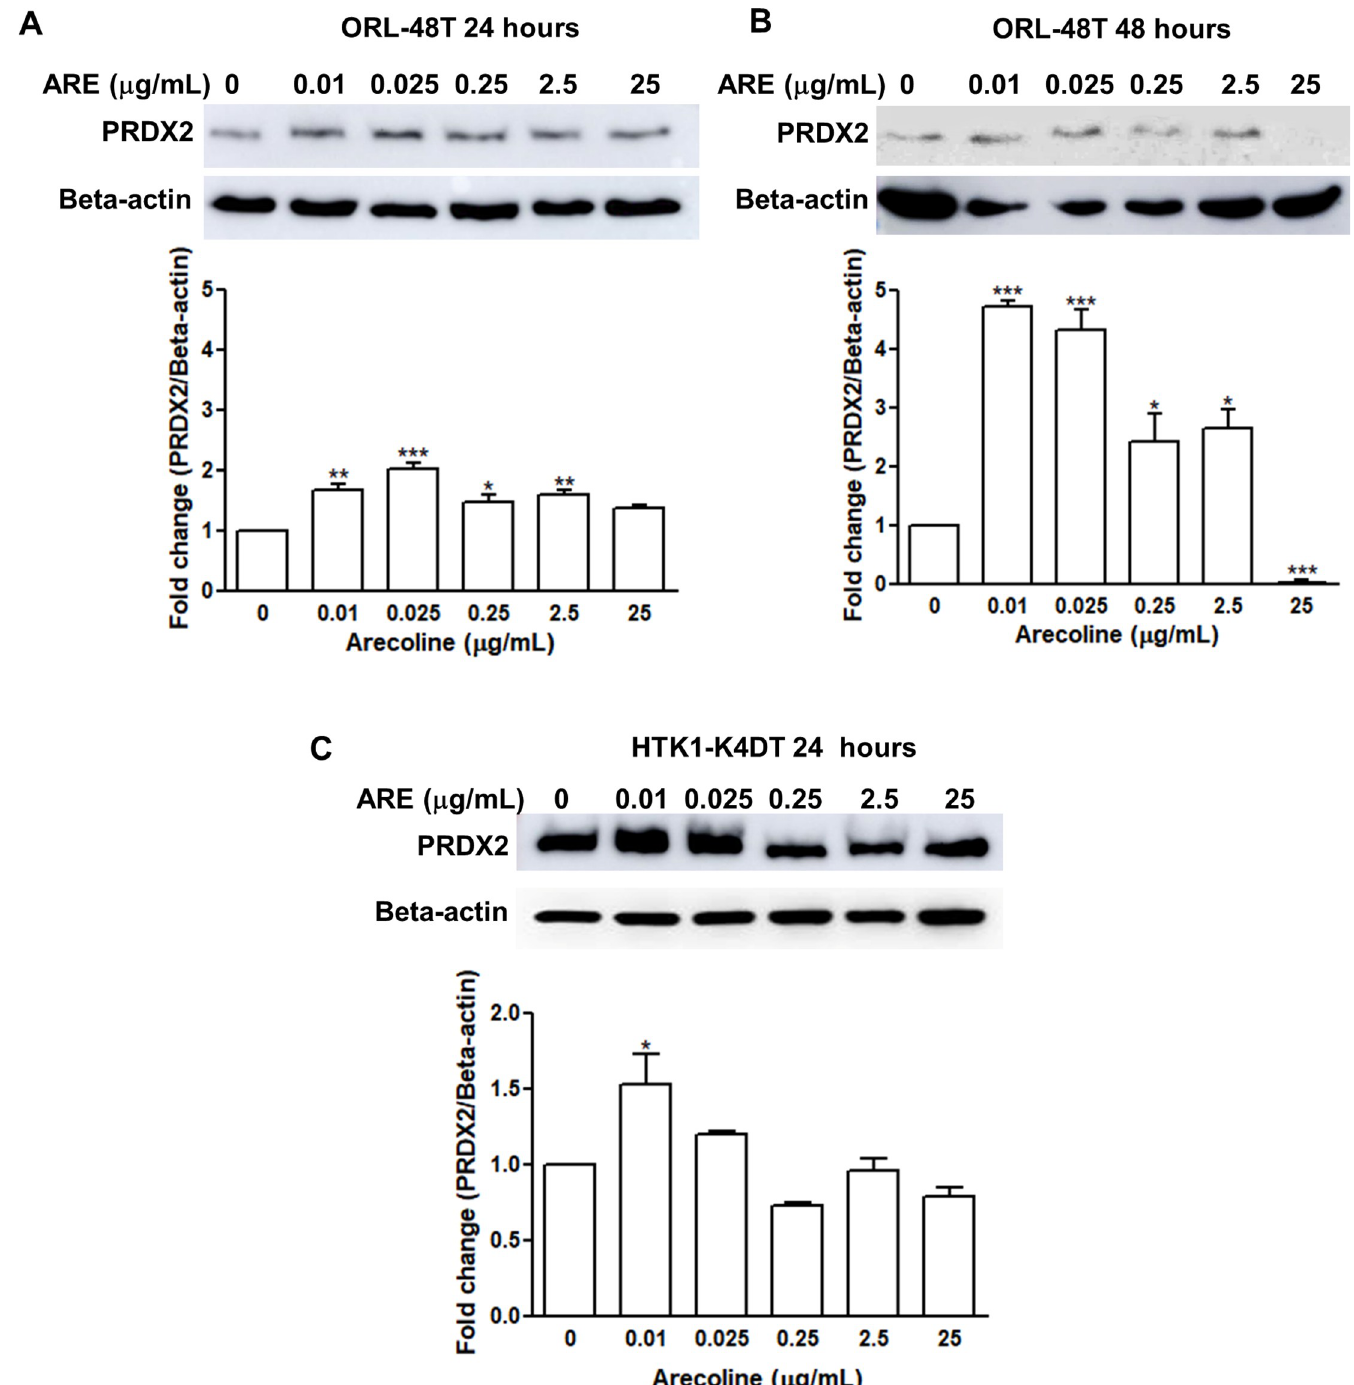
Fig 3. The level of PRDX2 protein expression in arecoline-treated oral cell lines. Oral cell lines, ORL-48T were treated with arecoline for 24 (A) and 48 (B) hours, and HTK1-K4DT for 24 (C) hours. Each experiment was performed in triplicate. The levels of PRDX2 protein was assessed by western blot. Beta-actin was used as an internal control. The protein intensity was measured using ImageJ 1.49v software. Fold change in protein intensity of PRDX2 was quantified. Differences in expression among 0–25 μ g/ml of arecoline treatment were statistically analyzed using One-way ANOVA. � and �� denote statistically significant differences as P < 0.05 and 0.01,